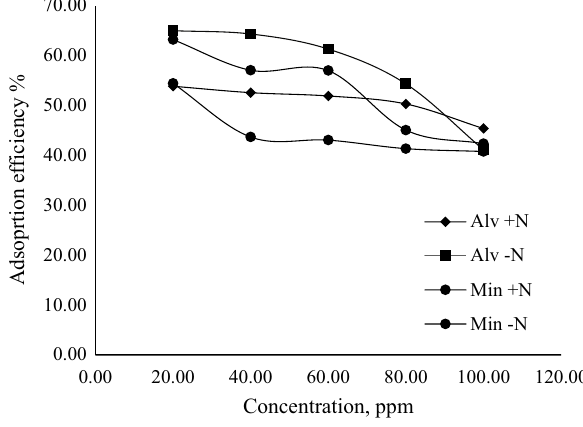
Fig. 3 Effect of initial ion concentration on the adsorption efficiency of Zn 2+ onto N. alveolaris + N, N. alveolaris –N, N. minuta + N, and N/ minuta –N algae